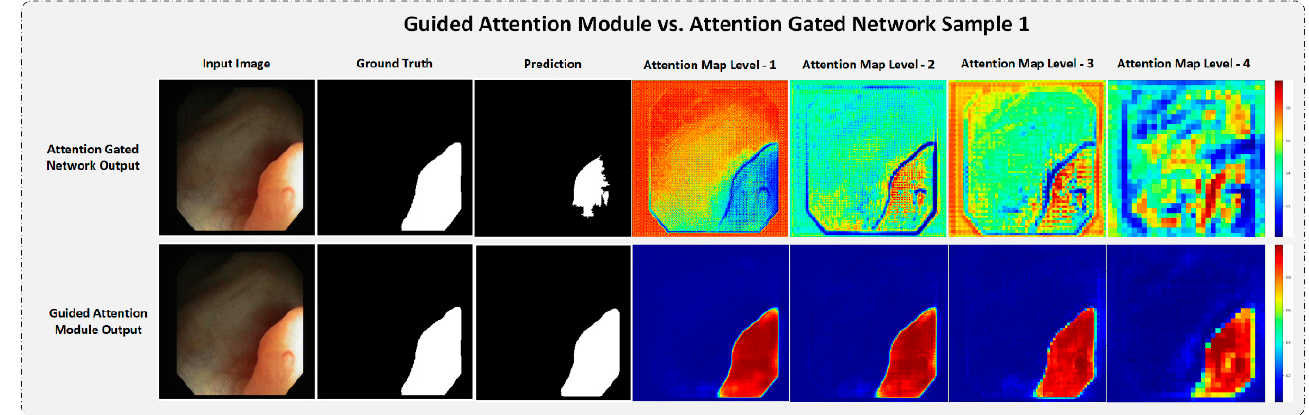
Figure 9. The attention visualization comparison: Attention Gated Network vs. Guided Attention Module with a test sample from CVC-ClinicDB dataset. Even in deeper layers, GAM is still able to capture refined attention maps, while Attention Gated Network only outputs coarse and broken attention maps.